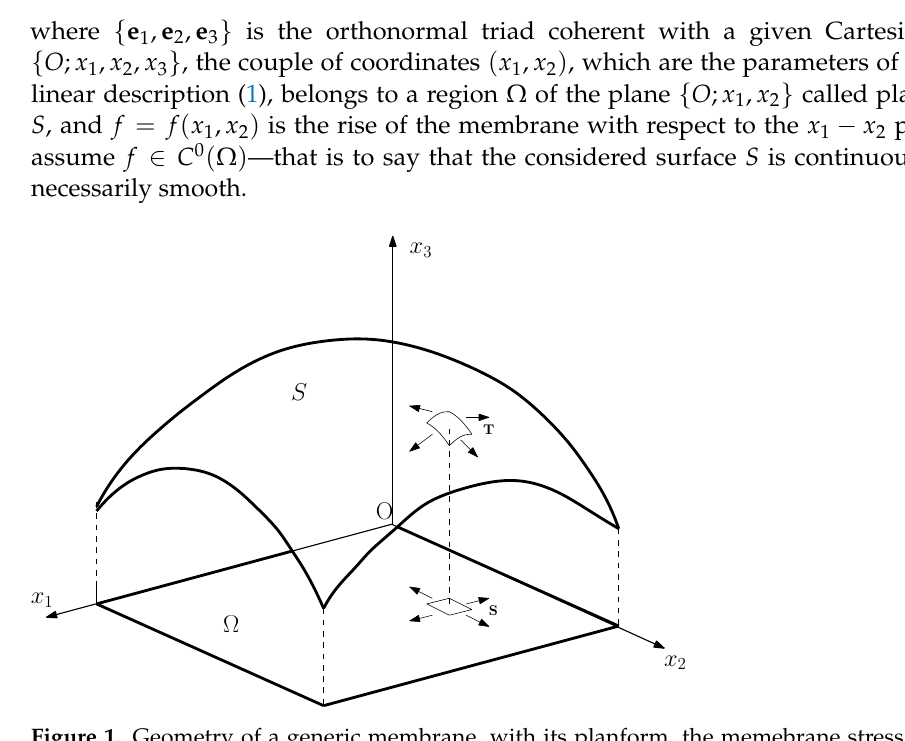
Figure 1. Geometry of a generic membrane, with its planform, the memebrane stress T and the Pucher (projected) stress S